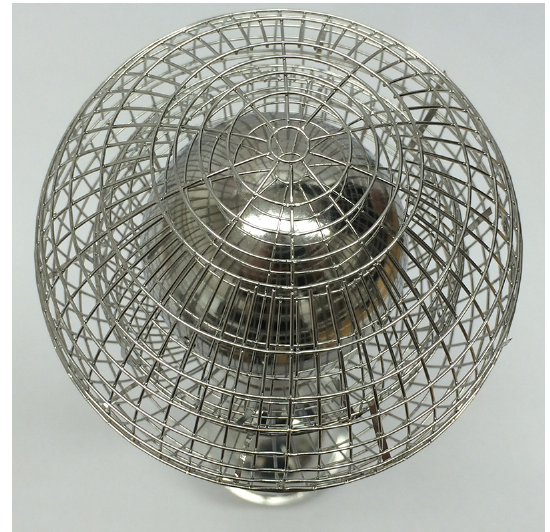
Figure 1. Meteoric Smoke Particle Detector with its central spher- ical electrode (26mm radius), shielded by two electrically biased concentric grids (35 and 45mm